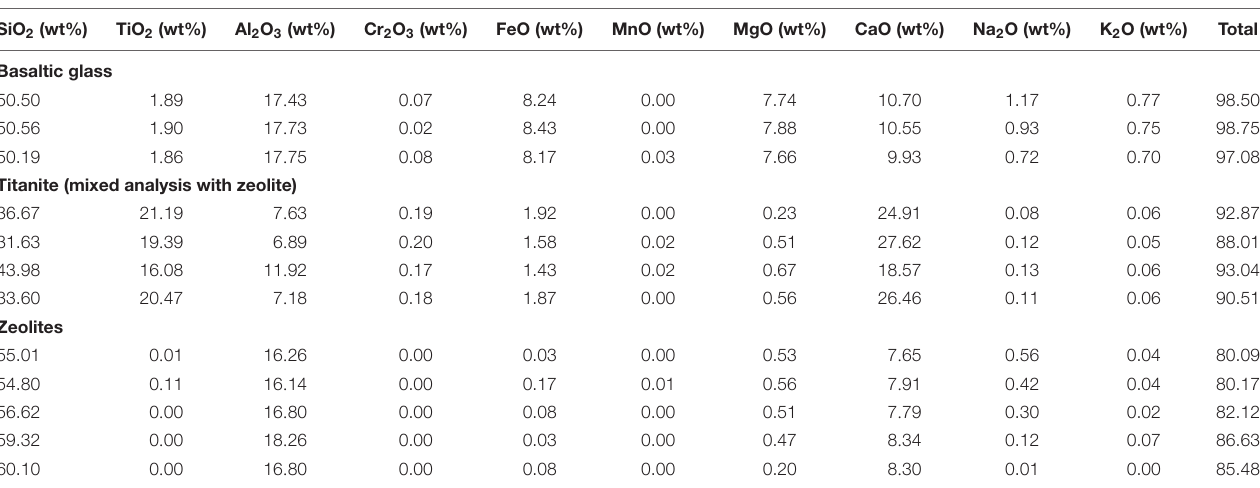
FIGURE 2 | Transmitted light photomicrographs at increasing magnification from (A–D) , showing the diversity of primary microtubule textures in Stonyford glasses. Tubules are rooted along exposed fracture surfaces (FS) and propagate into unaltered glass (pale brown). Most SFVC tubules are hollow and smooth-walled (HT), and many show complex knotted forms especially near their endpoints (KF). TABLE 1 | Quantitative analysis of SFVC minerals and glass by